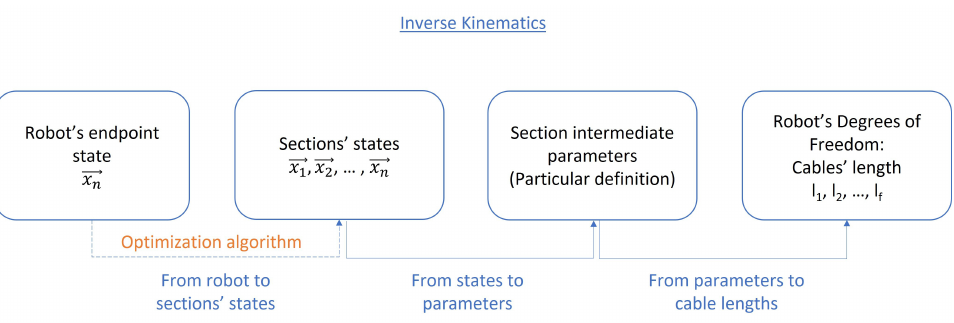
Figure 3. Summary of the different steps for inverse